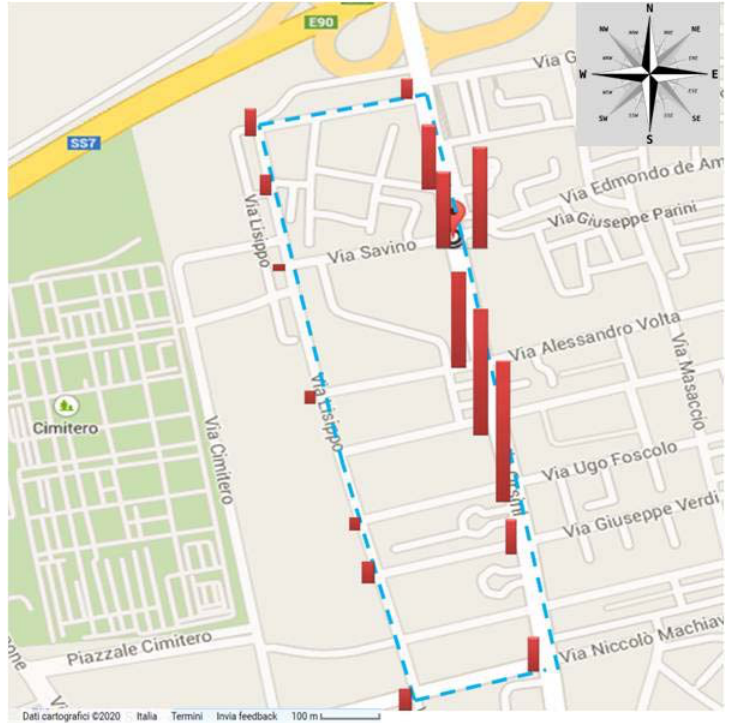
Figure 6. Visualization of the mean values of the total p-PAH concentrations at the 17 monitoring points along the pathway.